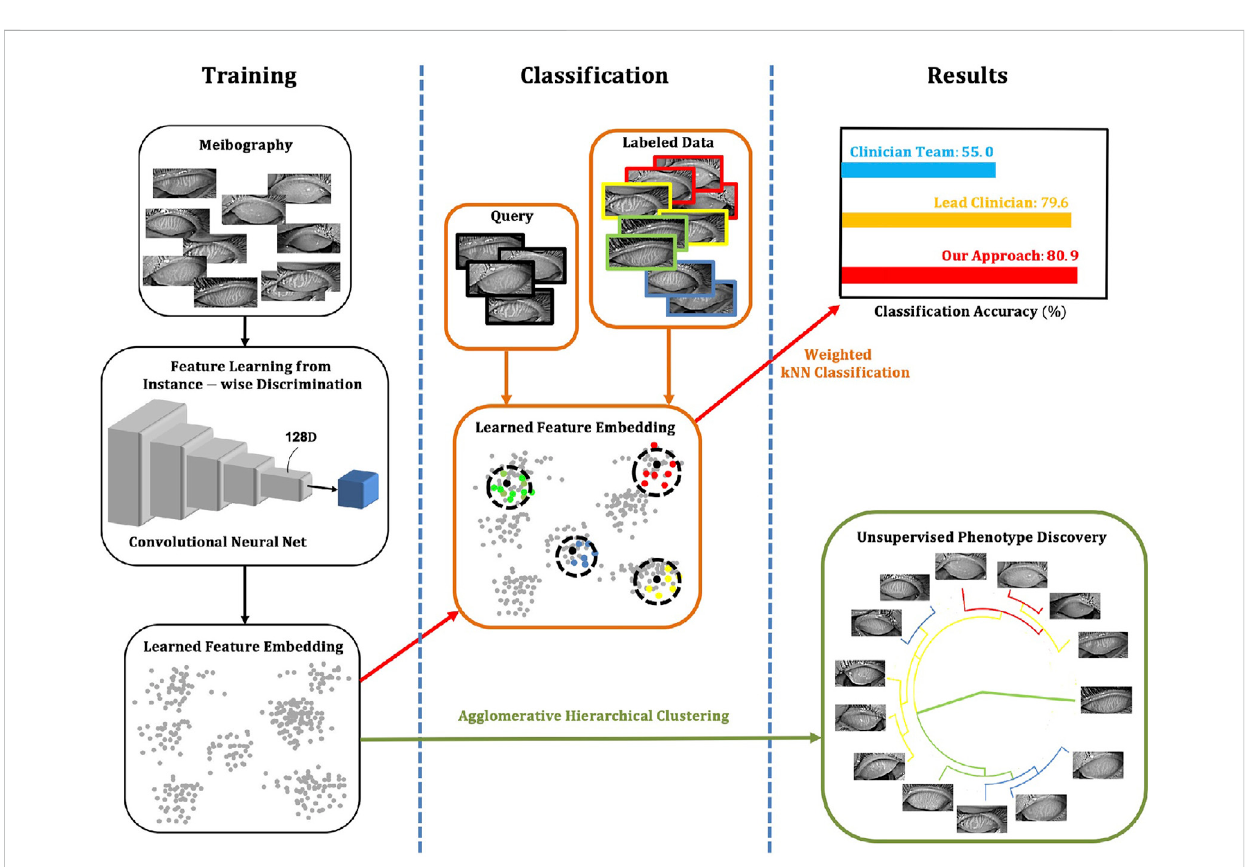
FIGURE 6 Overview of the approach (Yeh et al., 2021). The NPID is applied to learn a metric by feeding unla-beled meibography images and then to discriminatethemaccordingtotheirvisualsimilarity.Thisapproachmeasuresatrophyseverityanddiscoverssubtlerelationshipsbetweenmeibogra-phy images. There is no required image labeling, serving as ground truth for